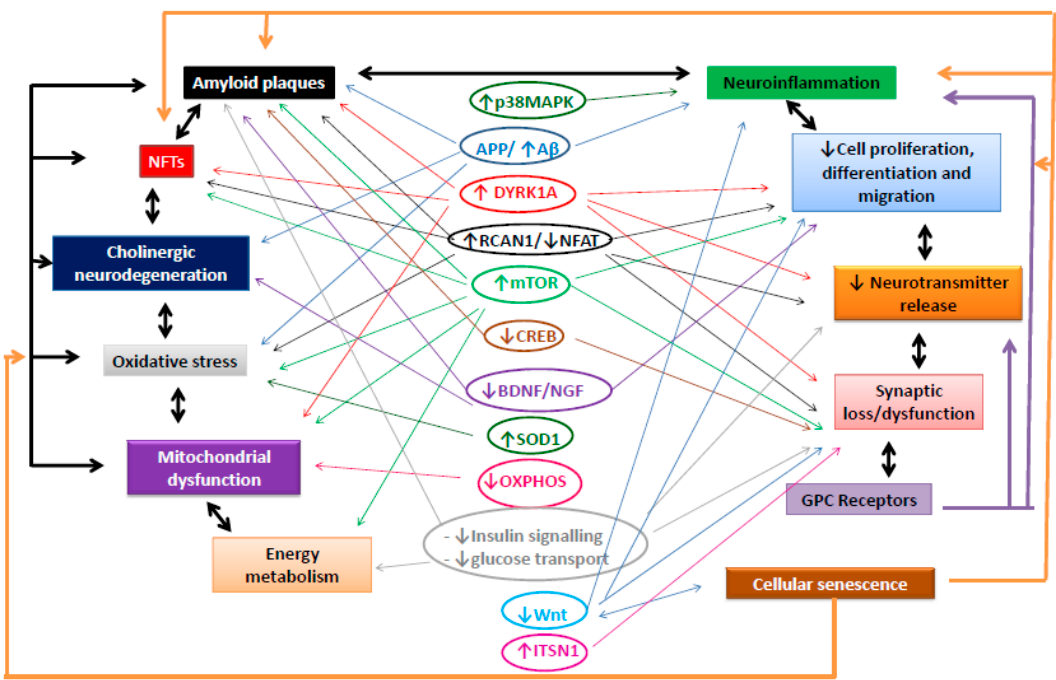
Figure 1. Graphical display of the main pathways (circled) implicated in each pathological characteristic of AD (squared) as well as their interconnections. Line and arrow colors depict the influence of the di ff erent signalling pathways and / or pathological characteristics circled or squared using the same color on other pathways or systems. Black arrows represent the feedback loops between the main pathological characteristics of AD. ↑ : up-regulated, ↓ down-regulated.